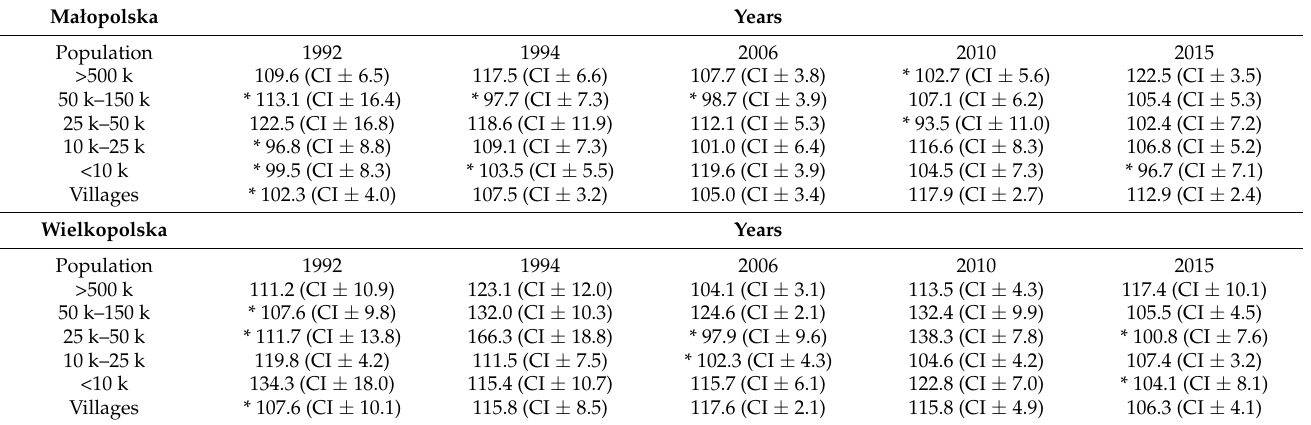
Table 4. Mortality from cardiovascular diseases during heatwaves calculated as percentage of the expected number of deaths during the time heatwave occurred. The 90% confidence intervals are in brackets. Statistically insignificant results are marked with *.